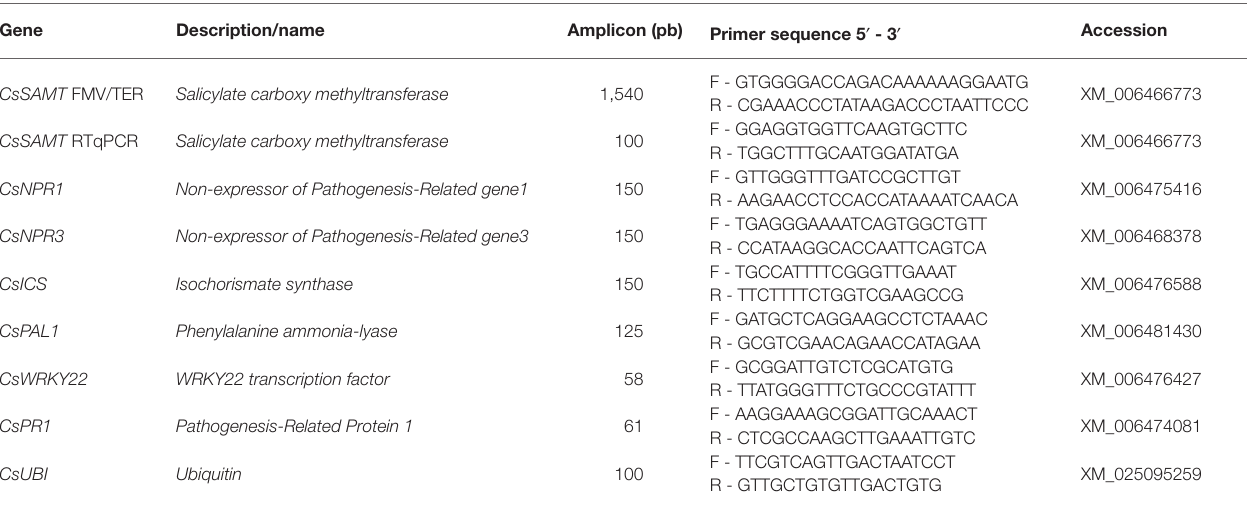
TABLE 1 | List of primers used for PCR and RT-qPCR